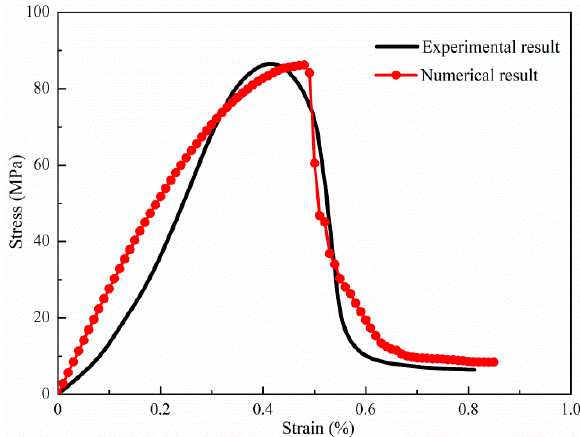
Figure 17. Comparison of stress–strain curves of specimen 1 between the experimental test and numerical simulation.